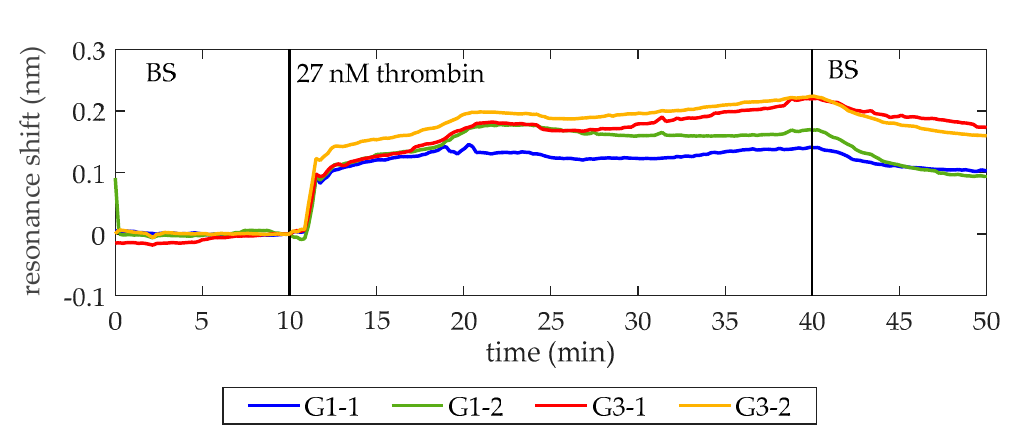
Figure 4. Sensing response of the PC sensing structures when a 27 nM thrombin solution is flowed. At minute 10, 27 nM thrombin solution in BS is flowed (it reaches the photonic chip one minute later) and its binding to TBA on the surface is clearly observed. At minute 40, BS is flowed again to remove the excess of thrombin. An average spectral shift of 97 pm and 166 pm is observed for the structures from groups G1 and G3, respectively. The bumps that appear while flowing 27 nM thrombin are ascribed to fluidic irregularities.